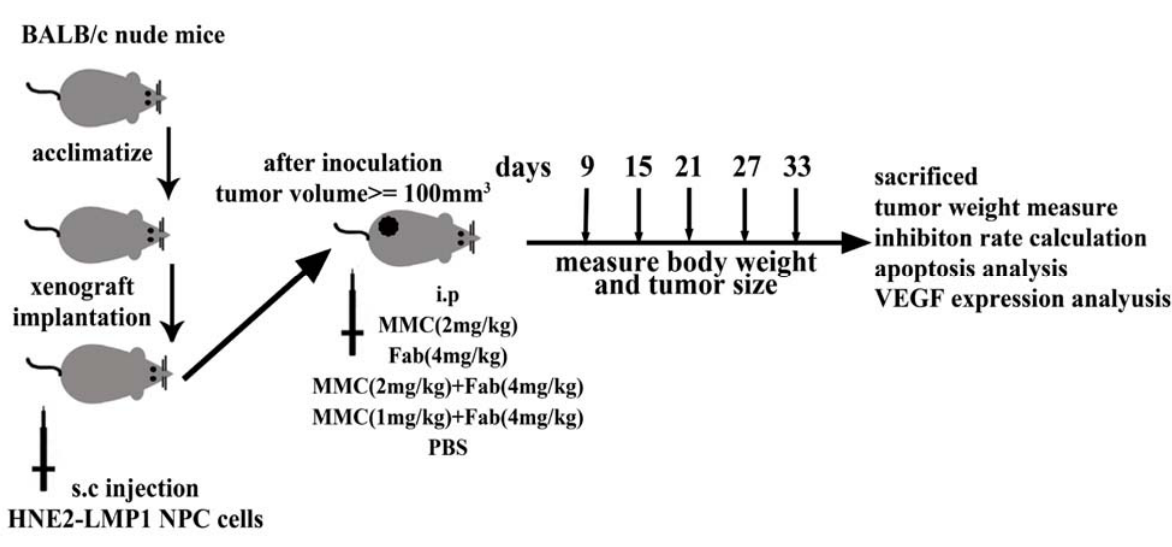
Figure 4. Experimental design of NPC xenograft nude mice model. The mice were s.c. implanted with HNE2-LMP1 cells for about 7 days until tumor volume reached around 100 mm 3 and then randomly divided into five groups and treated as described in Materials and